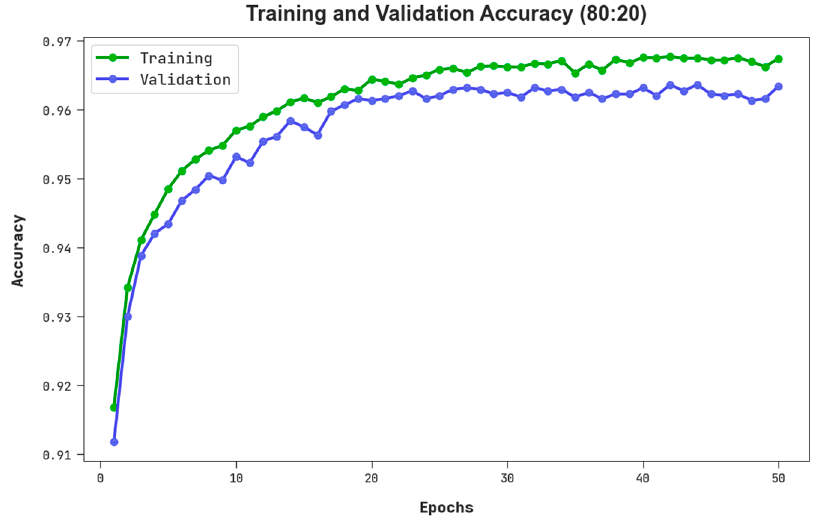
Figure 5. TACC and VACC outcome of RHSODL-AMD system on 80:20 of TRS/TSS.